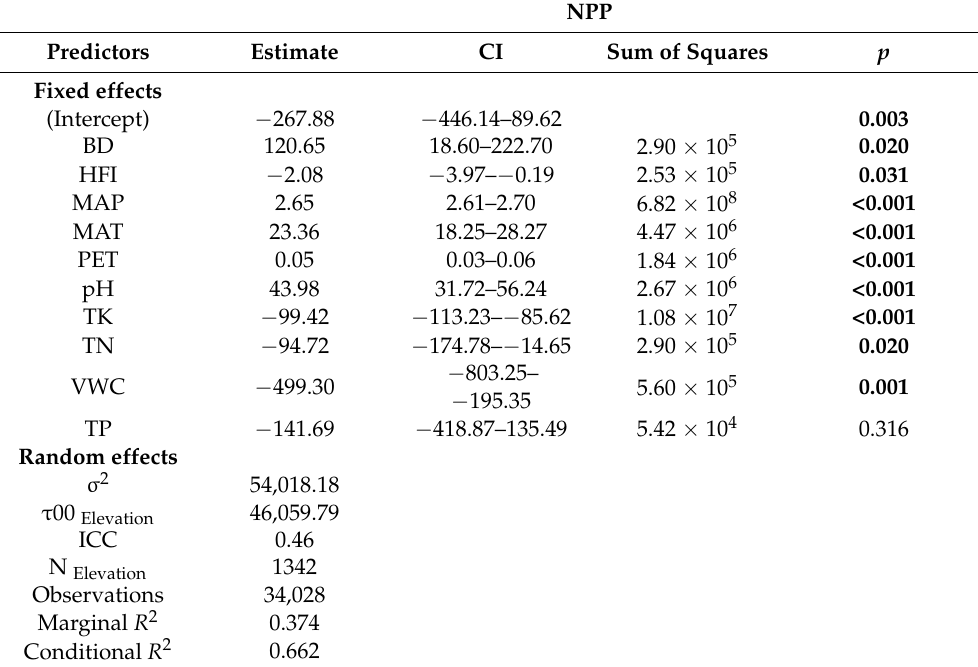
Table 3. Statistics for the best model of the relationships between the various drivers and net primary production. Model estimates (mean coefficient estimates) with a 95% confidence interval (CI) and the model variation explained by the fixed effects alone (marginal R 2 ) and by both the fixed and the random effects (conditional R 2 ) are presented. Values exceeding the significance level are indicated in bold ( p <